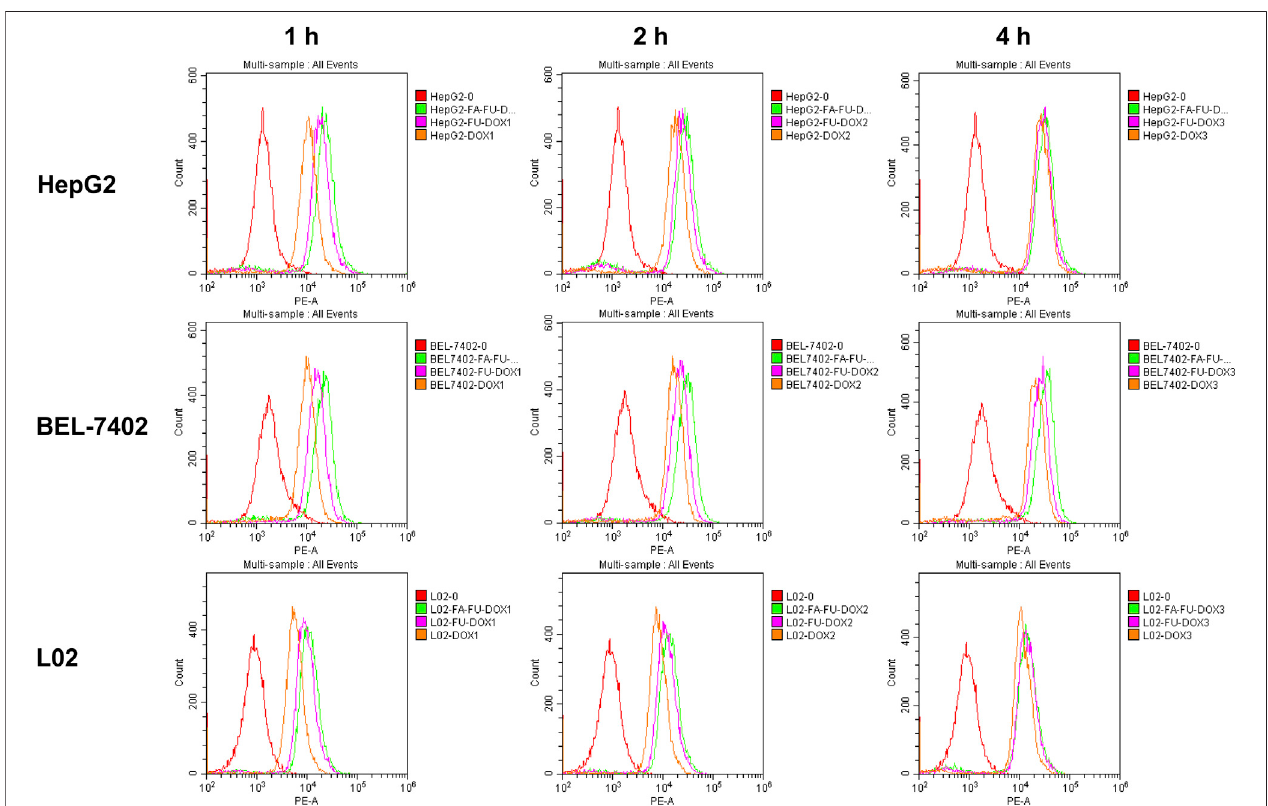
FIGURE 6 | Flow cytometry analyses of the intracellular accumulation of DOX, FU-DOX, and FA-FU-DOX in HepG2, BEL-7402, and L02 cells after 1-, 2-, or 4-h incubation.